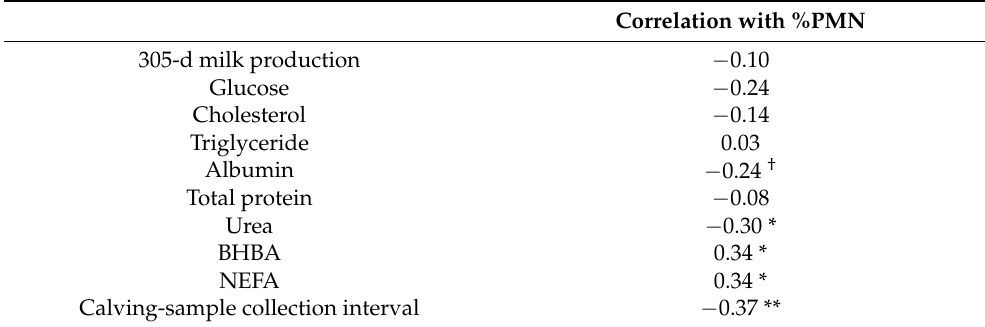
Table 1. Results of Pearson correlation between the analyzed variables and the percentage of poly- morphonuclear neutrophils